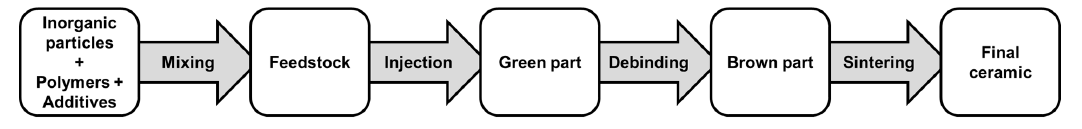
Figure 1. Ceramic injection molding processing steps.